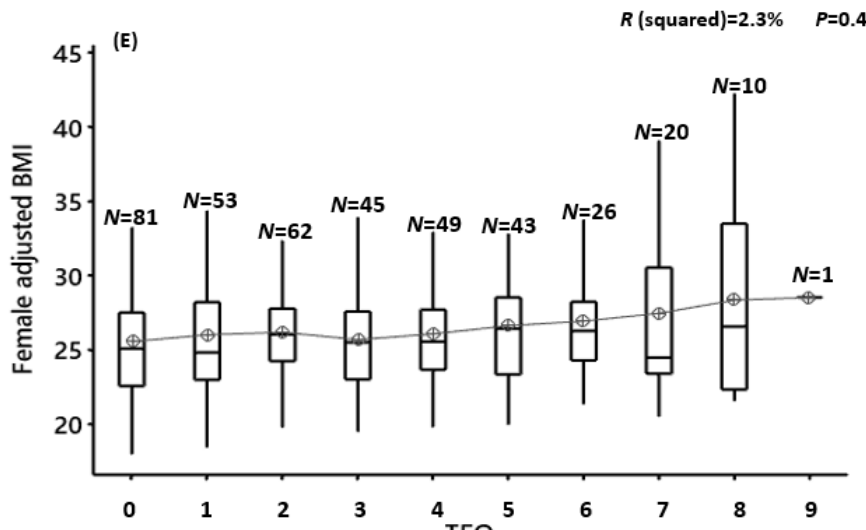
Figure 6. Female adjusted BMI vs. the frequency of food outlet usage for 7-consecutive days. ( A ) FSR = full-service restaurant, ( B ) FFR = fast-food restaurant, ( C ) delivery ( D ) take-away and ( E ) TFOs = total food outlets, N = number of participants in each group. Results of the ANOVA are shown. Significance is where p < 0.01 (after Bonferroni correction).